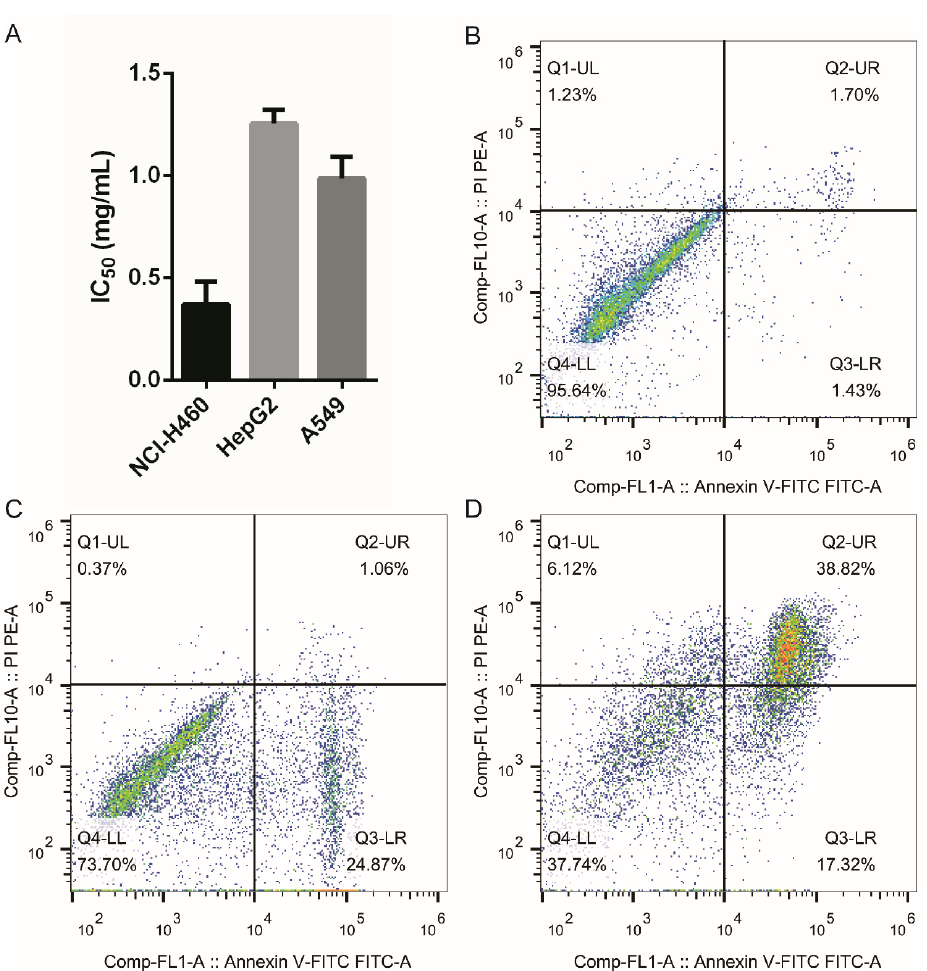
Figure 3. HTDT-6-2-3-2 induced cell death in a dose-dependent manner. ( A ) IC 50 values of HTDT-6-2-3-2 on three cancer cell lines were determined. The result showed HTDT-6-2-3-2 exhibited strong anti-proliferation activity on NCI-H460, HepG2, and A549 human cancer cell lines, with an IC 50 value of 0.3686 ± 0.0935 mg/mL, 1.2564 ± 0.0548 mg/mL, and 0.9867 ± 0.0857 mg/mL, respectively.